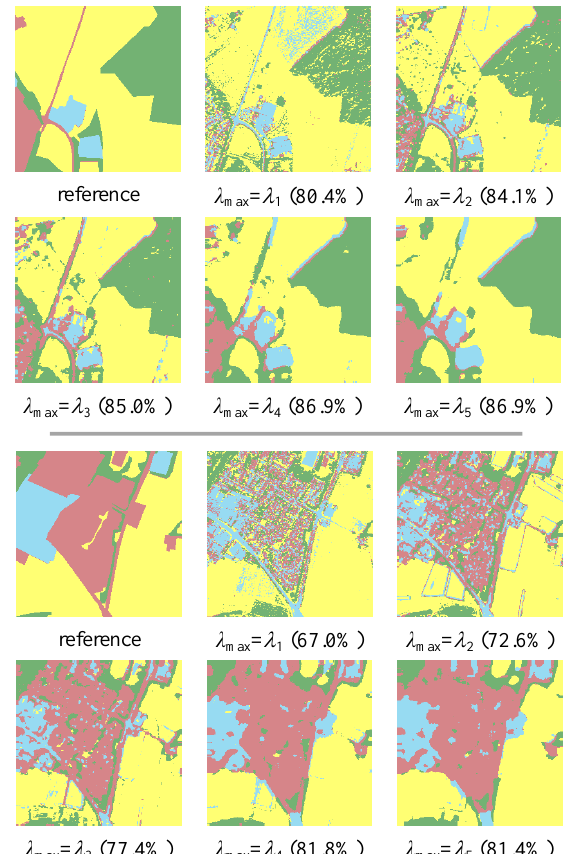
Figure 2. Overall accuracy of ML-classification in dependence on applied maximum scale λ max for feature extraction.